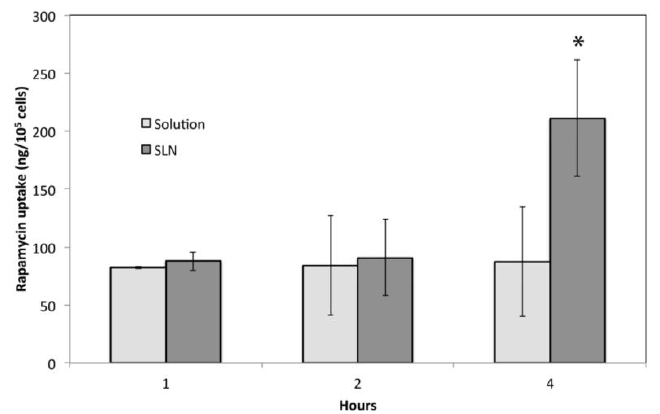
Figure 7. Cell uptake of SLN. Amount of Rp taken up by SH-SY5Y cells after 1, 2 and 4 h after the treatment with 200 nM Rp-SLN and Rp solution. * p < 0.001.